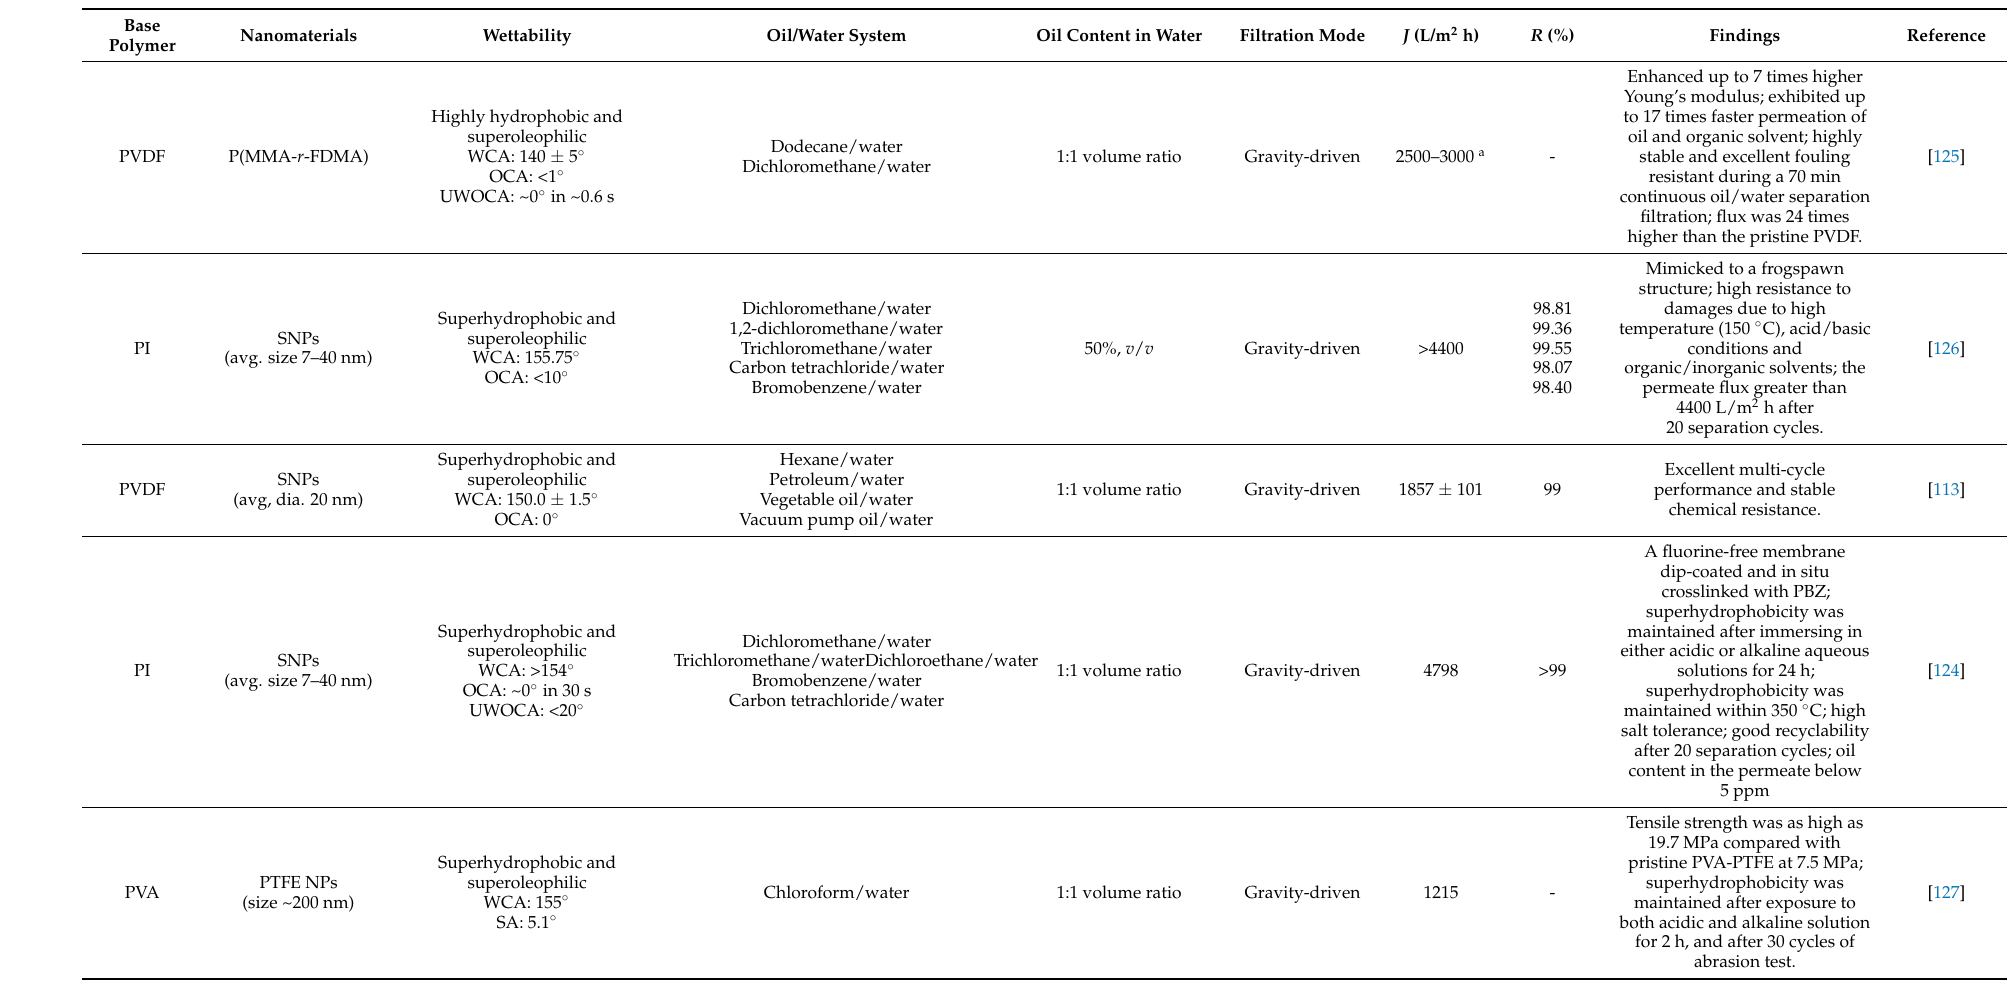
Table 3. Application of nanomaterials in the nanofiber membranes for the oil/water mixture